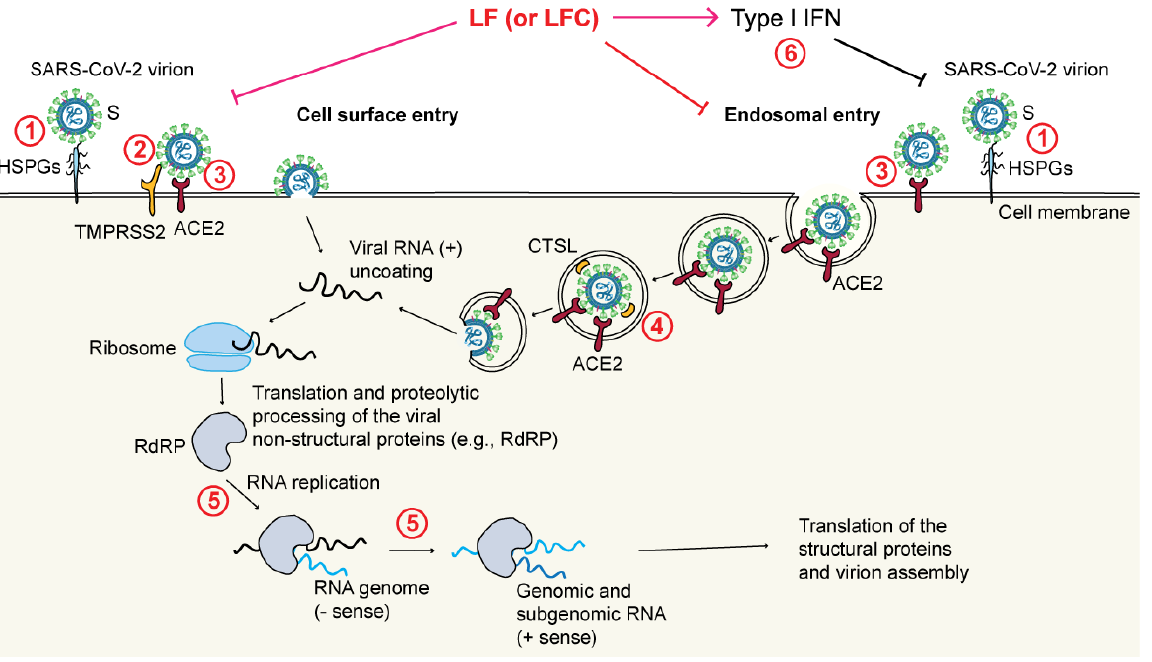
Figure 3. LF and LFC can interfere with SARS-CoV-2 infection through various mechanisms. SARS-CoV-2 enters cells via two different routes: (i) via the cell surface, mediated by binding to HSPGs and ACE2 with S protein processing by the cell surface serine protease TMPRSS2, which is required for membrane fusion and subsequent infection, or (ii) via endosomes, in which HSPGs, ACE2, and the endosomal cysteine protease CTSL play a role. LF has been shown to interfere with both pathways, due to binding to HSPGs (1) or directly to the S protein (3), and due to inhibition of CTSL that cleaves the S protein to release the virus from the endosome (4). Furthermore, LF has been found to inhibit viral replication by directly targeting the viral RNA-dependent RNA polymerase (RdRP, 5). Lastly, LF can boost the antiviral response through enhancing type I IFNs (6). So far, LFC has been shown to inhibit viral entry by inhibition of the protease TMPRSS2 (2).